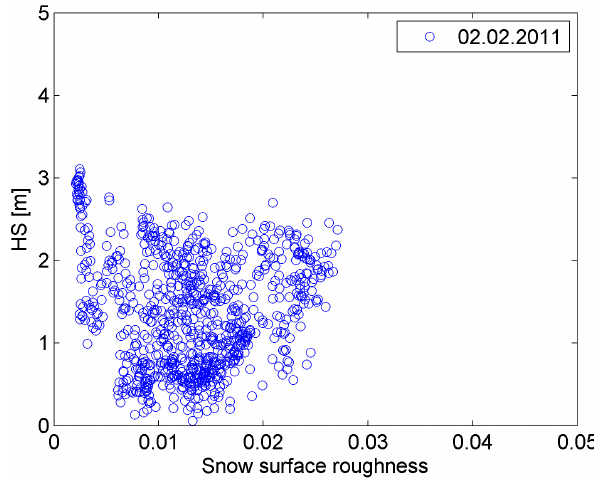
Fig. 10. Snow surface roughness as a function of snow depth for pixels with terrain roughness of 0.025 ± 0.001. Example for acqui- Fig. 10: Snow surface roughness as a function of snow depth sition of 2 February 2011 and a scale of 15m in the basin for pixels with terrain roughness of 0.025 ± 0.001. Example for acquistion of 2 February 2011 and a scale of 15 m in the basin ST.